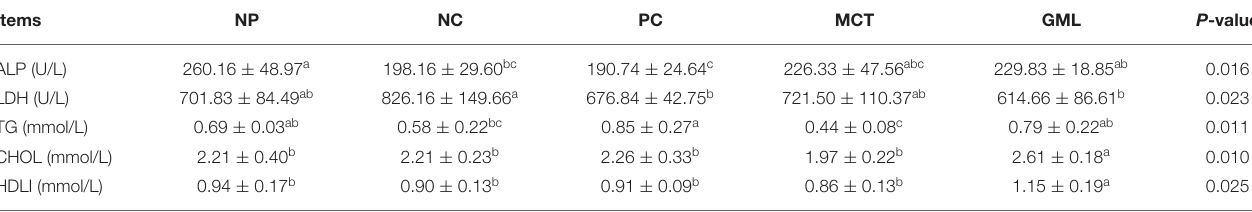
TABLE 2 | Effect of medium-chain fatty acid glycerides supplementation on serum biochemical indexes of piglets. Items